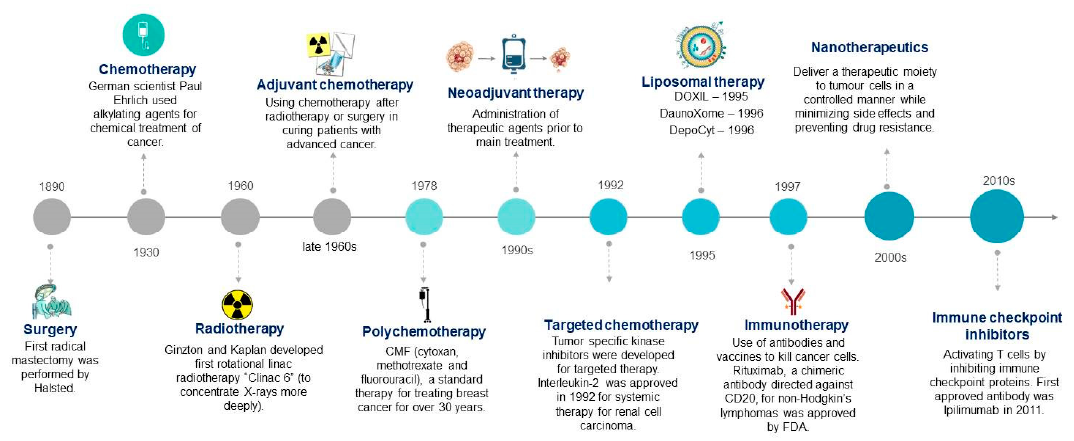
Figure 1. Evolution of cancer therapy techniques to date [3,4]. (Cliparts are adapted and modified from clipartlibrary.com)